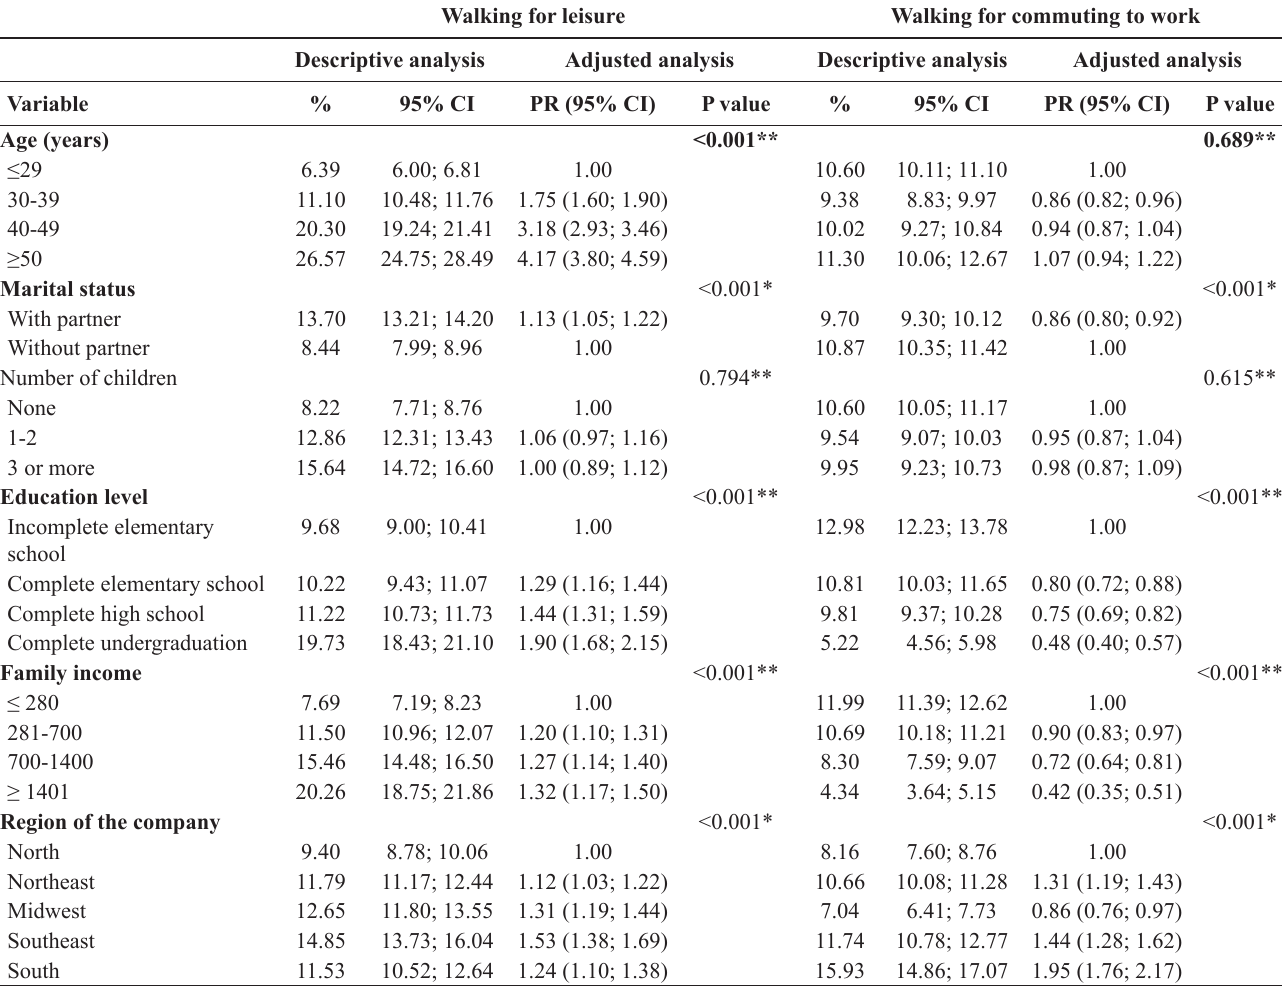
Table 2. Descriptive and adjusted analysis of habitual practice walking for leisure and commuting to work among Brazilian male industry work- ers. Brazil, 2008.